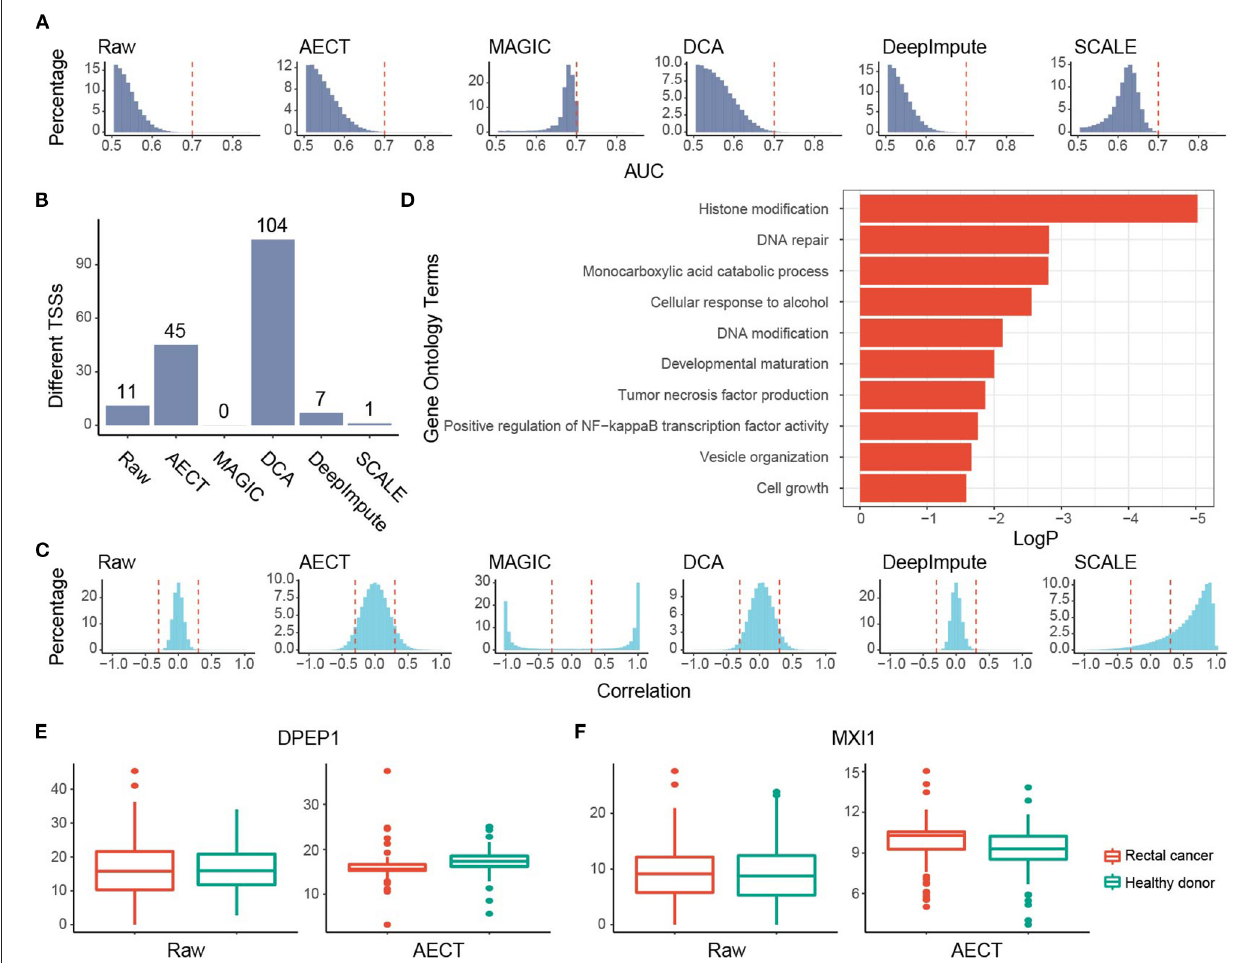
FIGURE 5 | Imputation performance of AECT and other algorithms on rectal cancer. (A) AUROC patterns for each TSS on rectal cancer detection; dashed lines represent AUROC = 0.7. (B) Rectal cancer-associated TSSs (FDR < 0.1, Wilcoxon rank-sum test adjusted by Holm procedure) identified by different algorithms. (C) Correlation patterns between TSSs; dashed lines represent Pearson correlation coefficients r = ± 0.3. (D) Gene Oncology enrichment of sex-different TSSs identified by AECT. (E,F) TSS coverage of (E) DPEP1 and (F) MXI1 in breast cancer, benign breast lesion, and healthy donor groups ( DPEP1 raw: p = 0.983; DPEP1 imputed by AECT, p = 5.75 × 10 − 4 ; MXI1 raw: p = 0.730; MXI1 imputed by AECT, p = 0.00146; Wilcoxon rank-sum